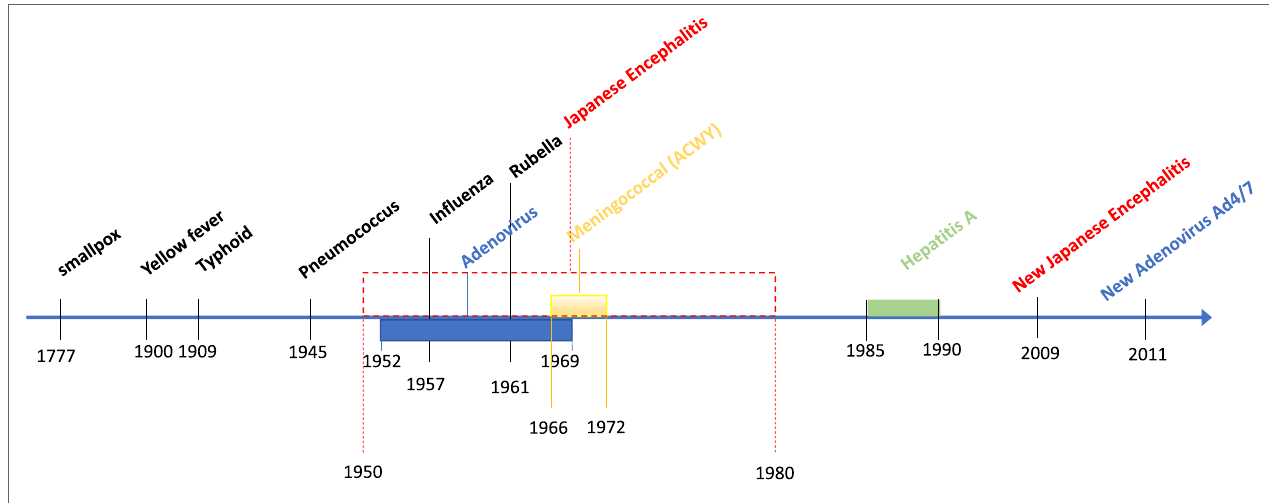
FigURe 1 | Timeline display of US military involvement in the research and development of major